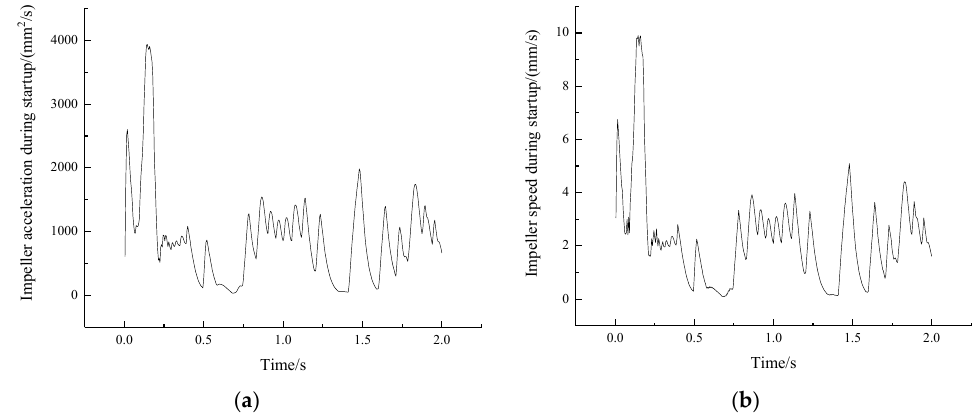
Figure 9. Dynamic curve of the impeller during startup of the centrifugal pump; ( a ) change in acceleration ( b ) change in speed.